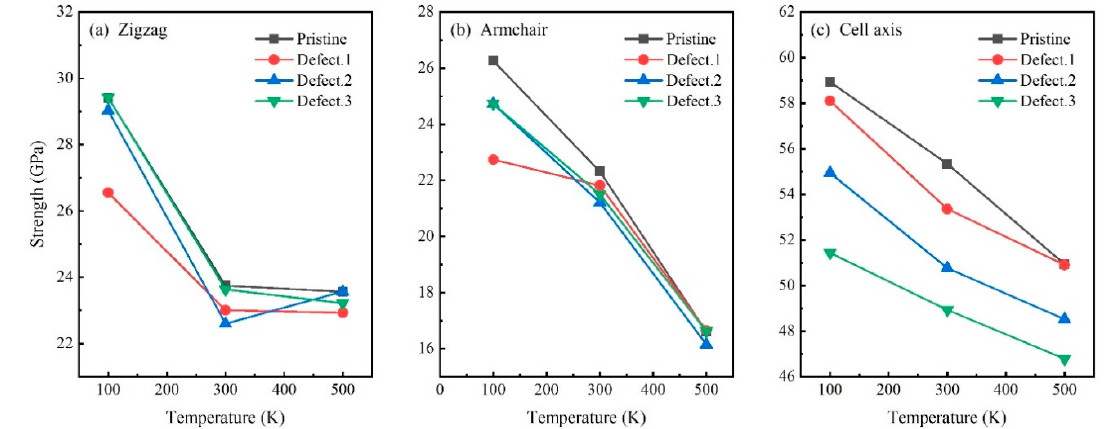
Figure 6. Temperature dependence. Engineering stress-strain curves of carbon honeycomb with different point defects at the temperature of 100 K, 300 K and 500 K, respectively. ( a ) zigzag, ( b ) armchair and ( c ) cell axis directions.